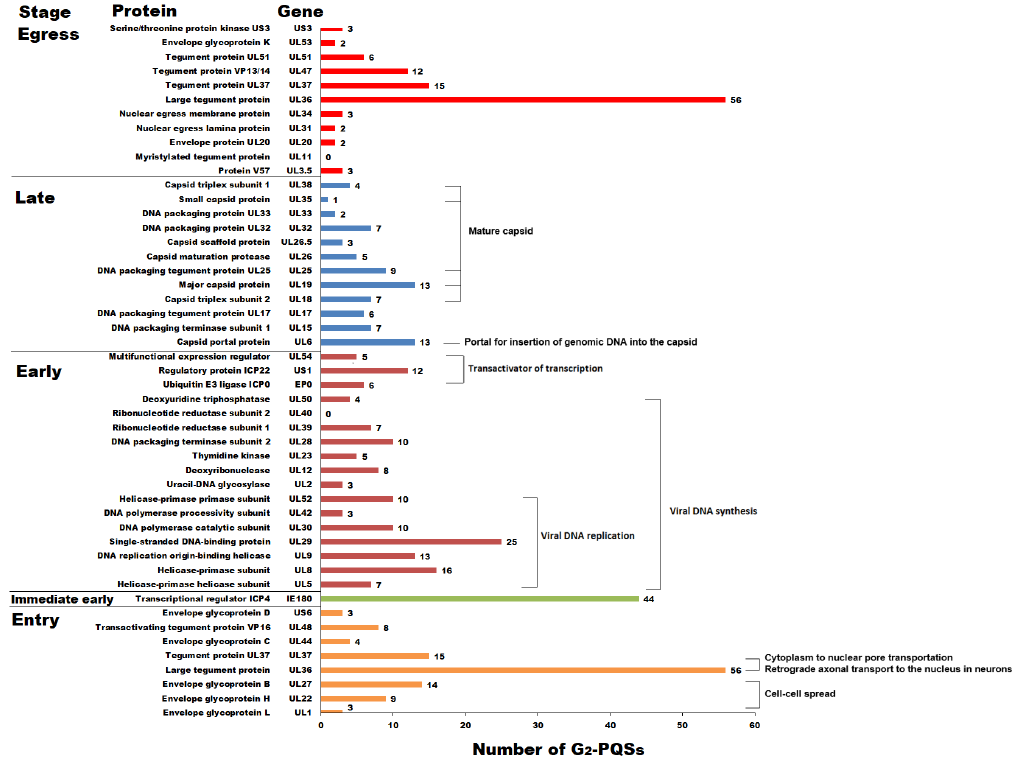
Figure 3. Number of G 2 -PQSs in the coding sequences of the genes that are involved in the PRV replication cycle.